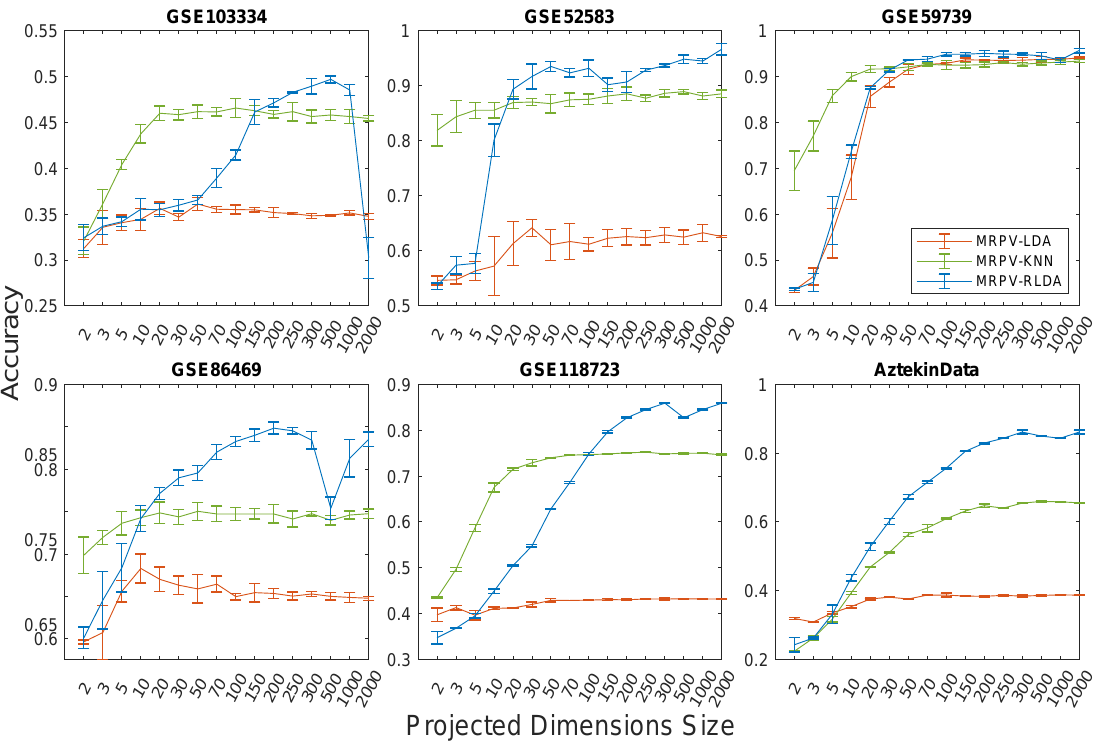
Figure 6. Error bars with the performance evaluation of the three MRPV-based algorithms accuracy (y-axis) in terms of the dimensions number selection (x-axis) of the random projection spaces. Starting from quite a small number of dimensions, we notice that the accuracy performance increases as the dimensions increase and, after one point (about 30 to 50 dimensions), the accuracy performance stabilizes. So, it can be concluded that the MRPV model works well in the small dimensions without having to project the initial data to higher